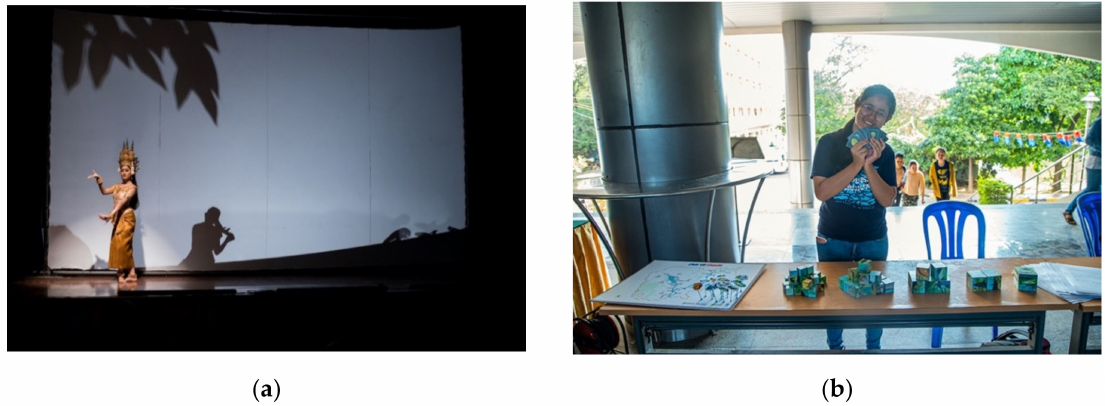
Figure 1. Conservation outreach festival in Phnom Penh: ( a ) Traditional shadow dance performance depicting a folk tale about a river dolphin; ( b ) a member of Young Eco Ambassador demonstrates an environmental